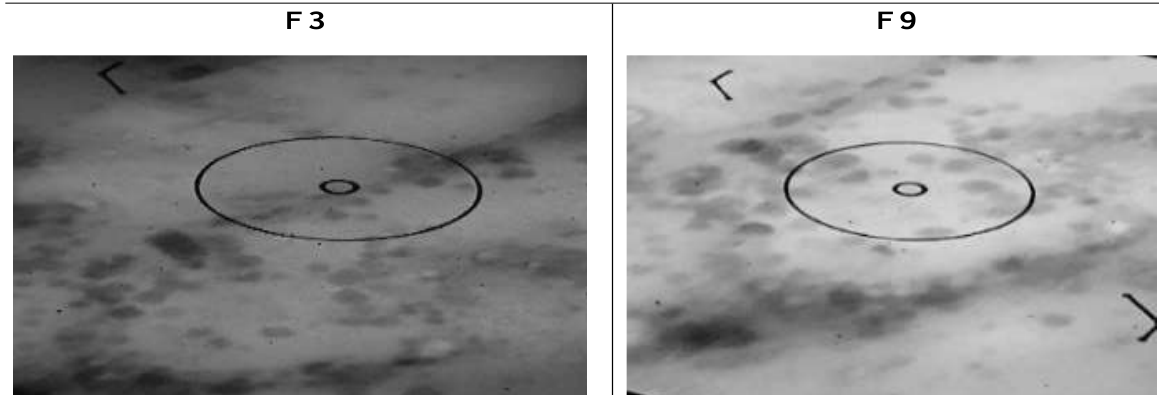
Figure 3. Transmission electron micrographs of LXM-loaded cubosomal